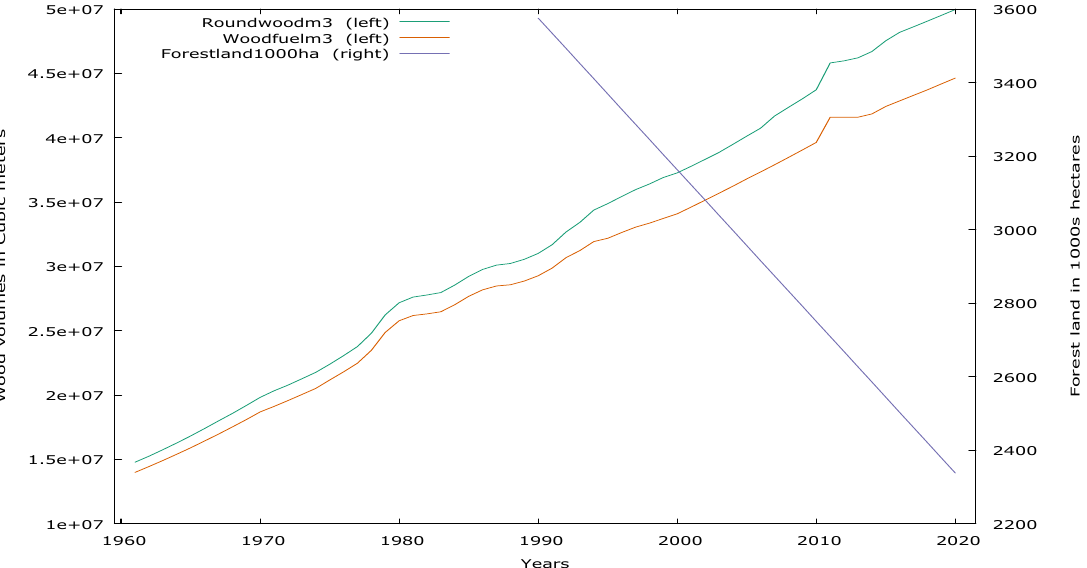
Figure 3. Trend analysis of total roundwood, total wood fuel production, and forestland (1961 to 2020), own analysis.